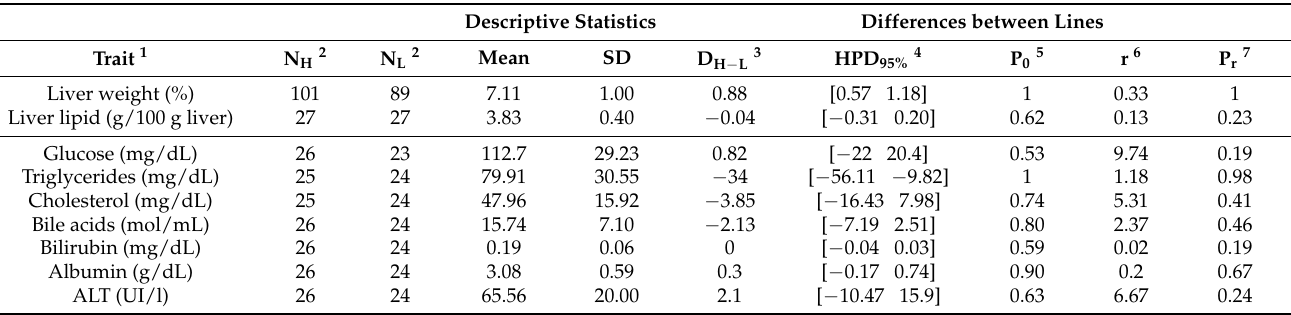
Table 3. Descriptive statistics and differences between lines of liver traits and plasma metabolites related to liver